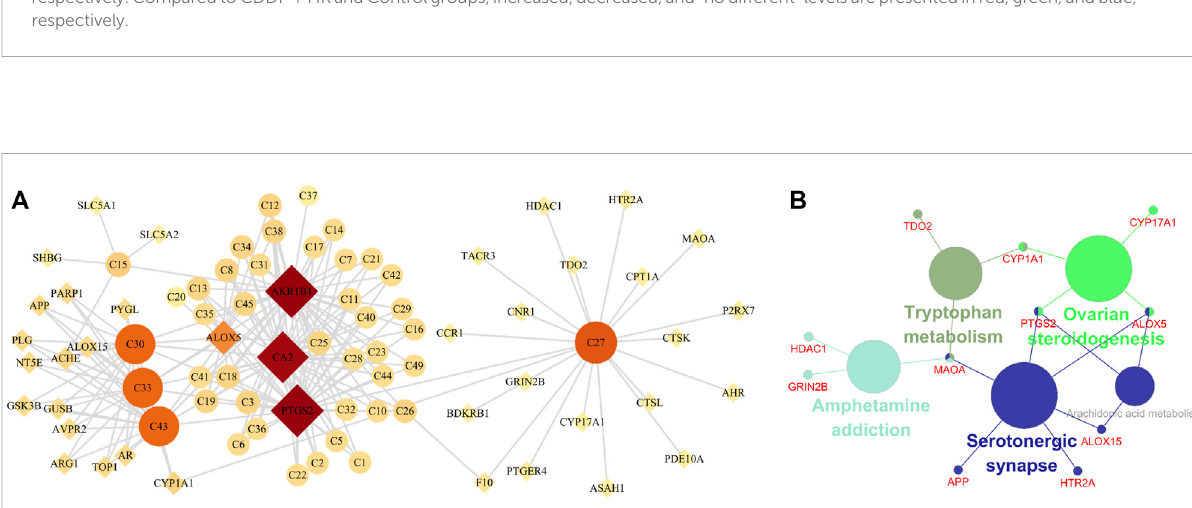
FIGURE 9 Networkpharmacologyanalysis. (A) Thecomponent-targetnetwork.CirclenodesindicateactivecomponentsinHK,diamondnodesrepresent the targets, and the size and color of the node are determined by the degree value. (B) KEGG enrichment